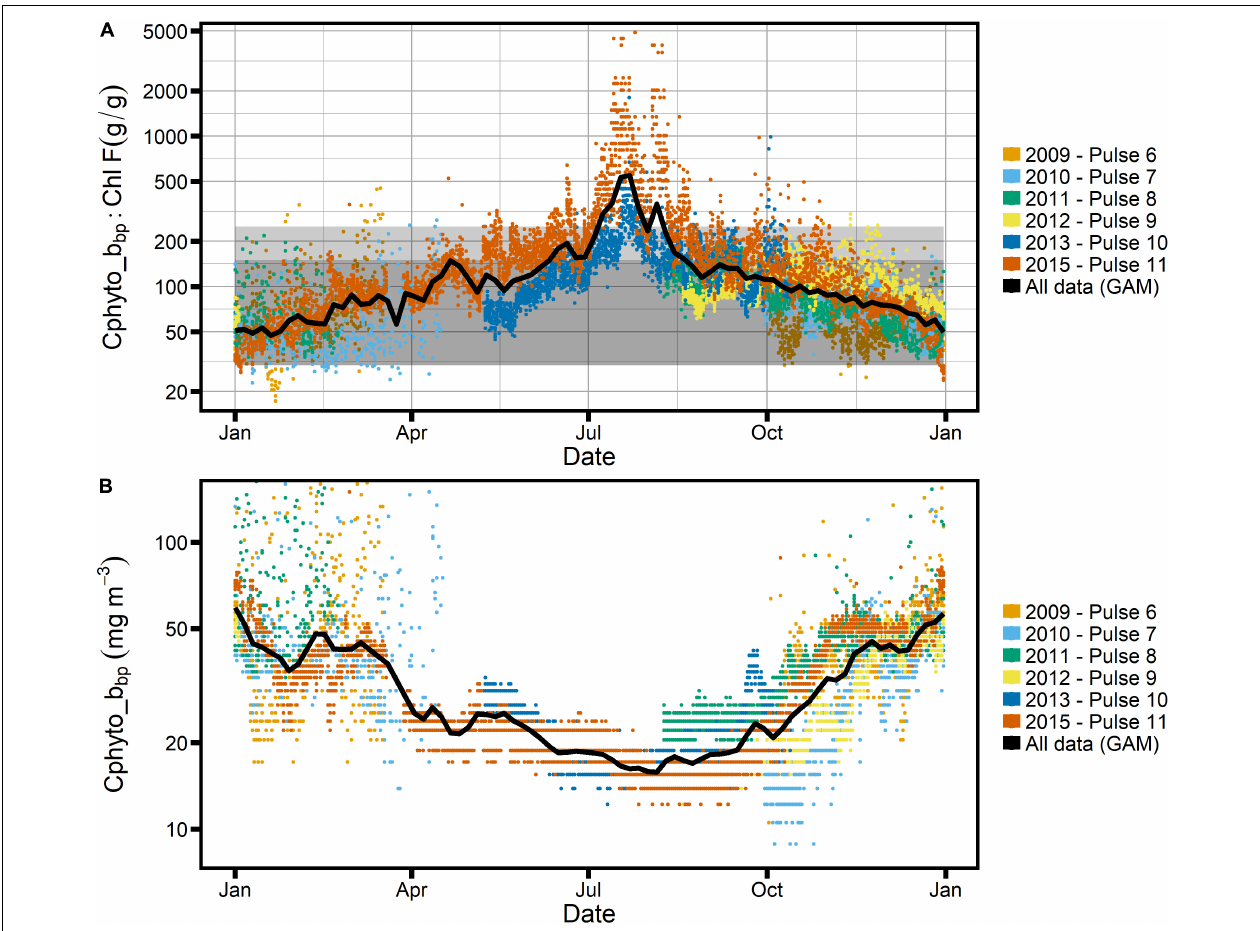
FIGURE 7 | (A) Ratio of Cphyto_b bp to Chl-F, with Cphyto_b bp estimated following Graff et al. (2015) and Haentjens et al. (2017); gray box as in Figure 6 . (B) Seasonal cycle of Cphyto_b bp . Note logarithmic scale for the y -axis in all panels.